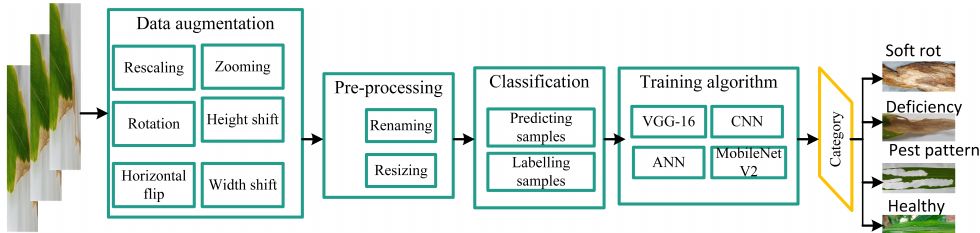
Figure 1. Proposed method for ginger plant disease detection using deep learning models.